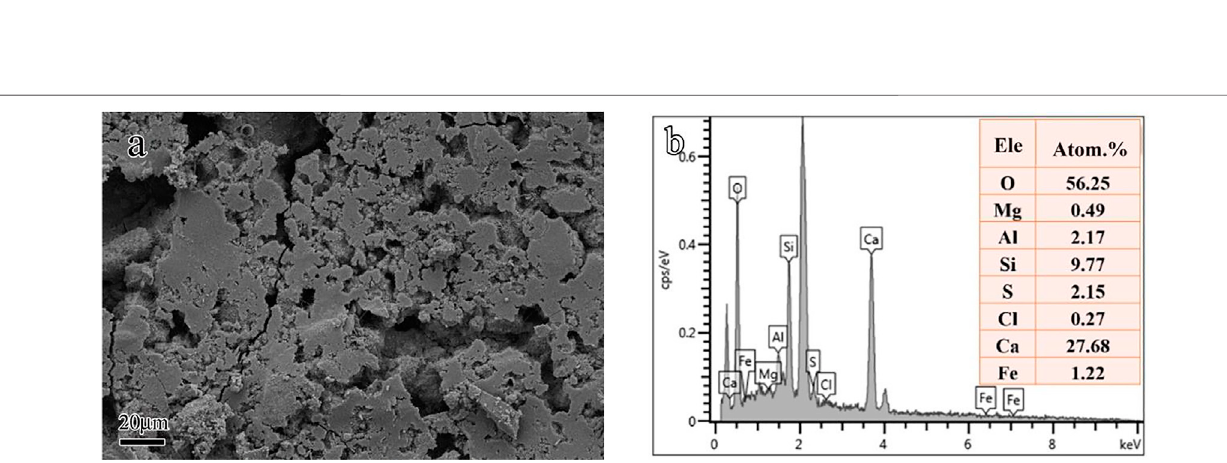
FIGURE 8 | SEM microstructure and the corresponding EDS results of the fracture surfaces of the cement paste in concrete without nano modi fi cation before F/T and W/D cycles.